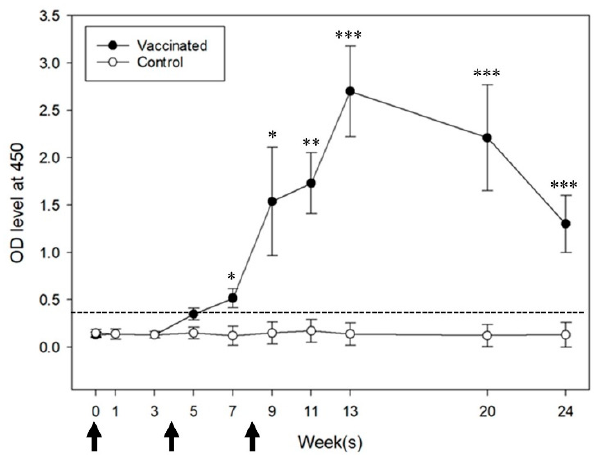
Figure 2. Anti-gonadotropin-releasing hormone (GnRH) IgG antibody response profile (1:50 serum dilution) of the vaccinated and control groups. Arrows on the x -axis indicate vaccination schedules in weeks 0, 4, and 8. The dashed line in the figure represents the assay cutoff point 0.384. * p < 0.05, ** p < 0.01, *** p < 0.001 (Student’s t-test).